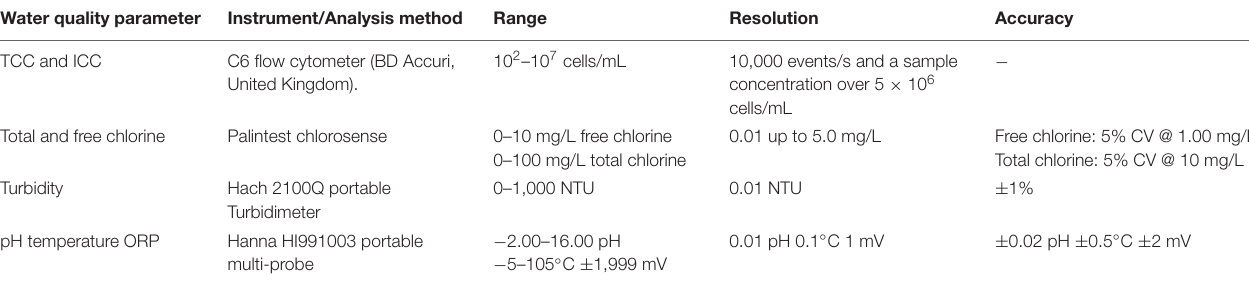
TABLE 2 | Methods used to measure discrete bulk water parameters ( n = 3) collected during laboratory and/or